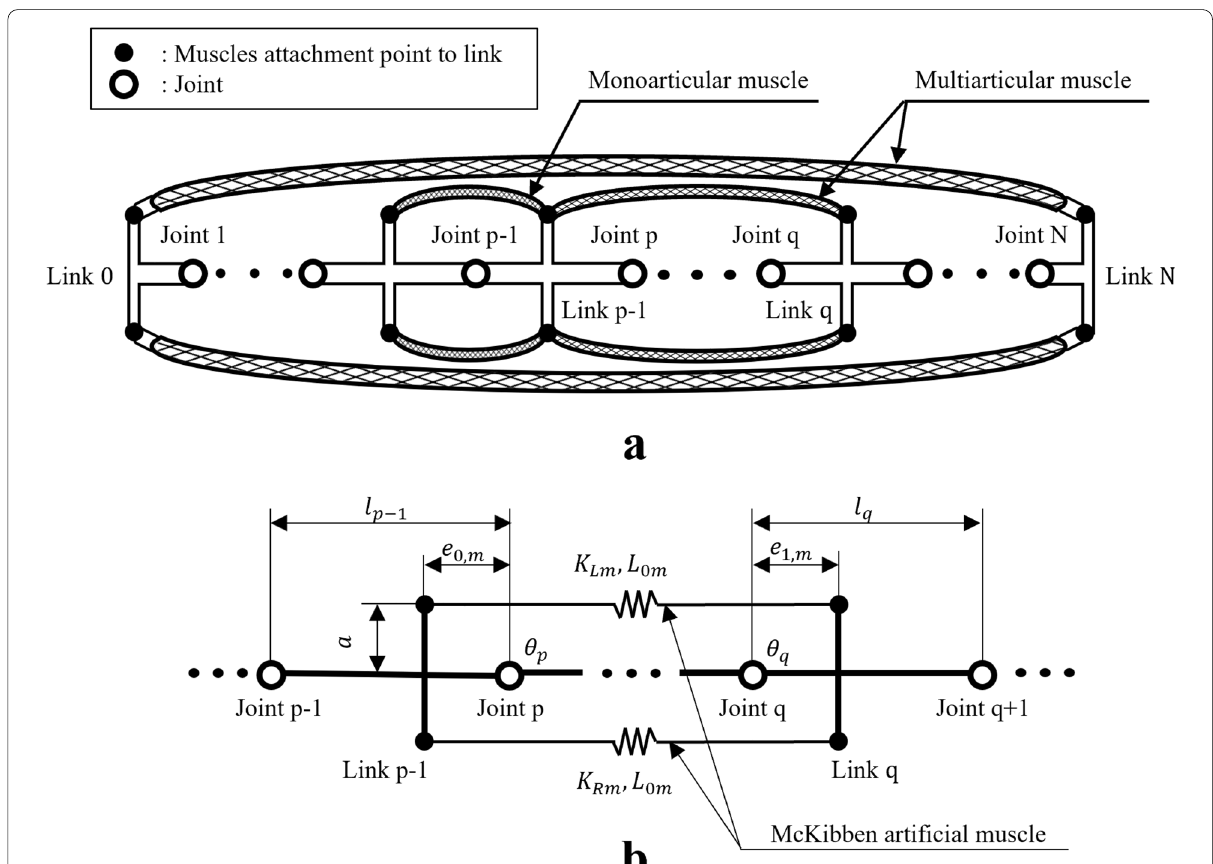
Fig. 3 Model of multi-serial-link mechanism driven by McKibben artificial muscles. a general view of N -serial-link mechanism driven by antagonistic mono- and multi-articular muscles and b mathematical model of a pair of antagonistic multiarticular muscles represented as springs. The stiffnesses of the left and right sides and the natural length of the m -th pair of the artificial muscles are denoted as K L , m , K R , m , and L 0, m ,